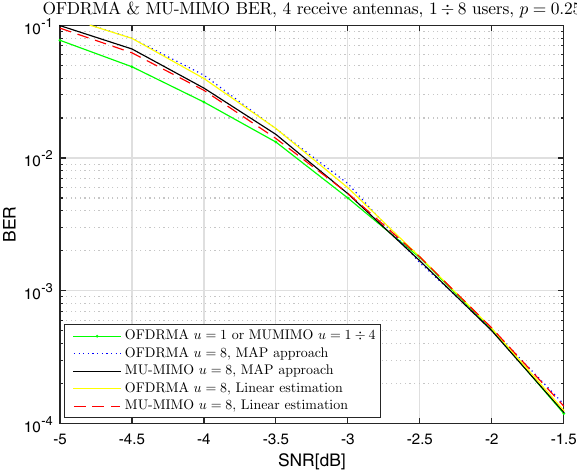
Figure 5. BER vs SNR, OFDRMA & MU-MIMO, QPSK, ϑ = 4 , u = 1 ÷ 8 , p = 0.25 .